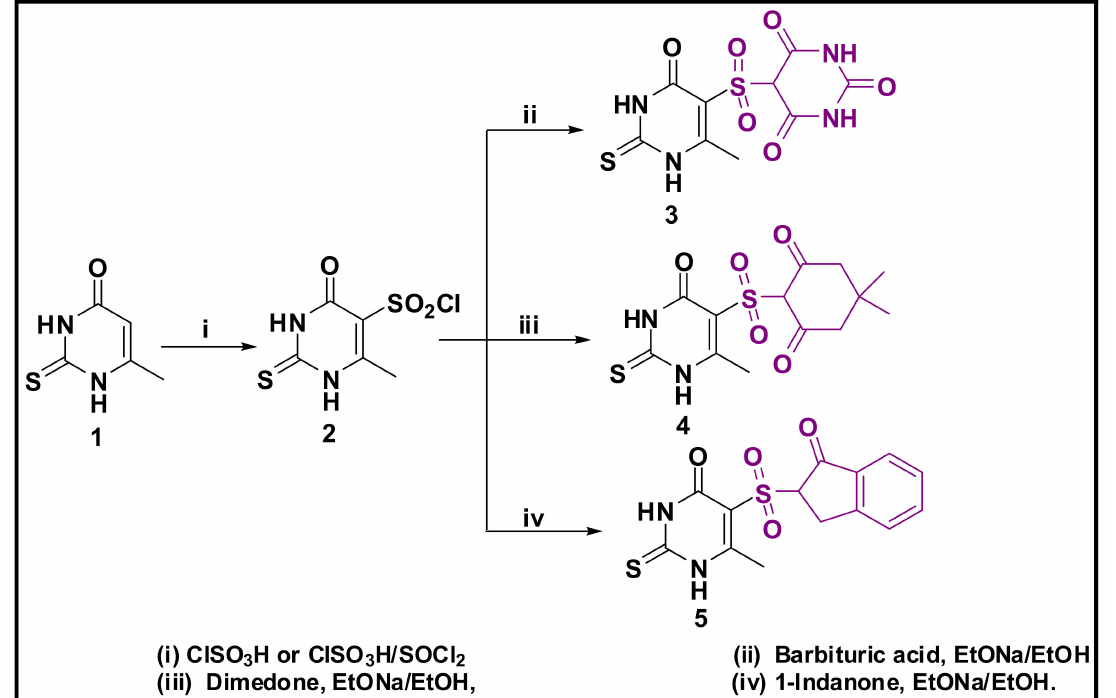
Scheme 1. Preparation of Sulfone derivatives 3 – 5